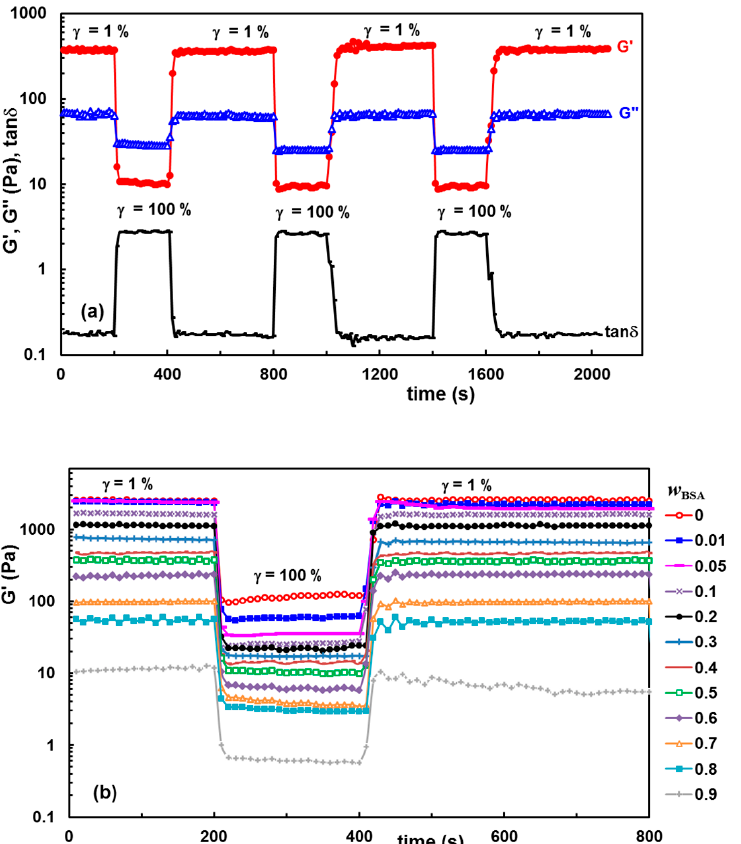
Figure 6. Self-healing behavior of hydrogels illustrated through consecutive step strain measurements at 37 °C: ( a ) G ′ , G ″ and tan δ for the hydrogel with w BSA = 0.5 during several successive runs of low (1%) and high (100%) strains; ( b ) G ′ for different polymer/protein compositions during the first run of strain (1%– ↑ 100%– ↓ 1%).